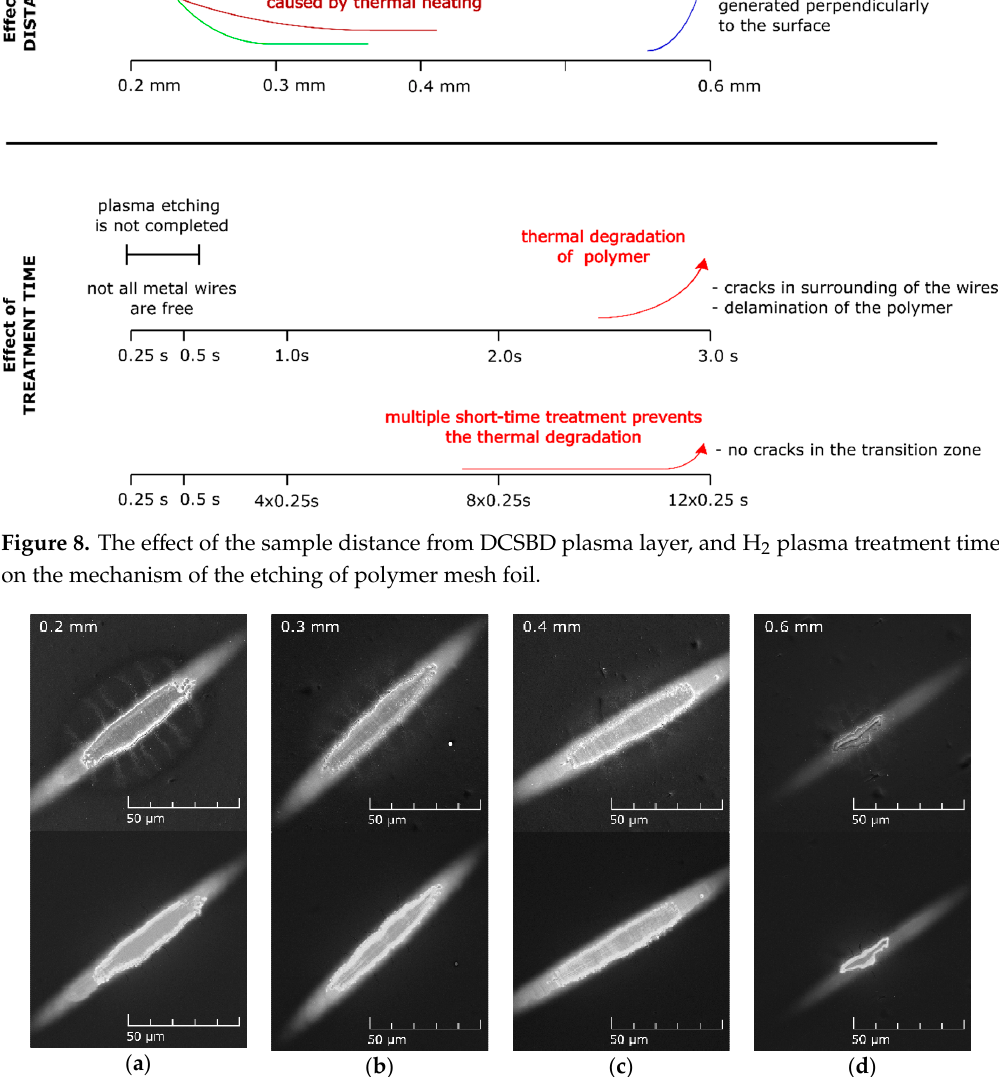
Figure 9. SEM micrographs of free metal wires after 1 s plasma etching in pure H 2 plasma at distance of 0.2 mm ( a ), 0.3 mm ( b ), 0.4 mm ( c ) and 0.6 mm ( d ). Top row—SE image; bottom row—BSE image.